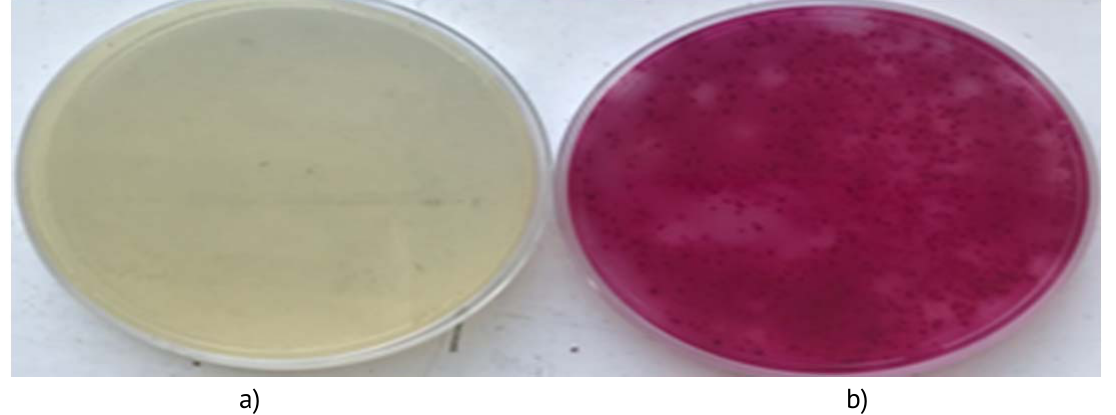
Figure 4. Growth of Salmonella Abony ATCC 6017strains in sausage samples tested after 72h: a) control sample; b) hawthorn sample.